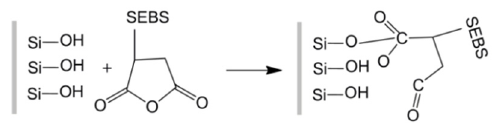
Figure 5. Chemical reaction between SEBS-g-MA and SGF.